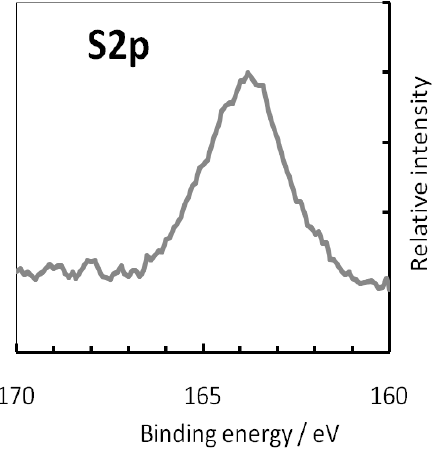
Figure 4. XPS (X-ray photoelectron spectroscopy) of S2p electrons on the surface of brass after 17 h immersion in the buffer solution with 0.01 mM MPATA.